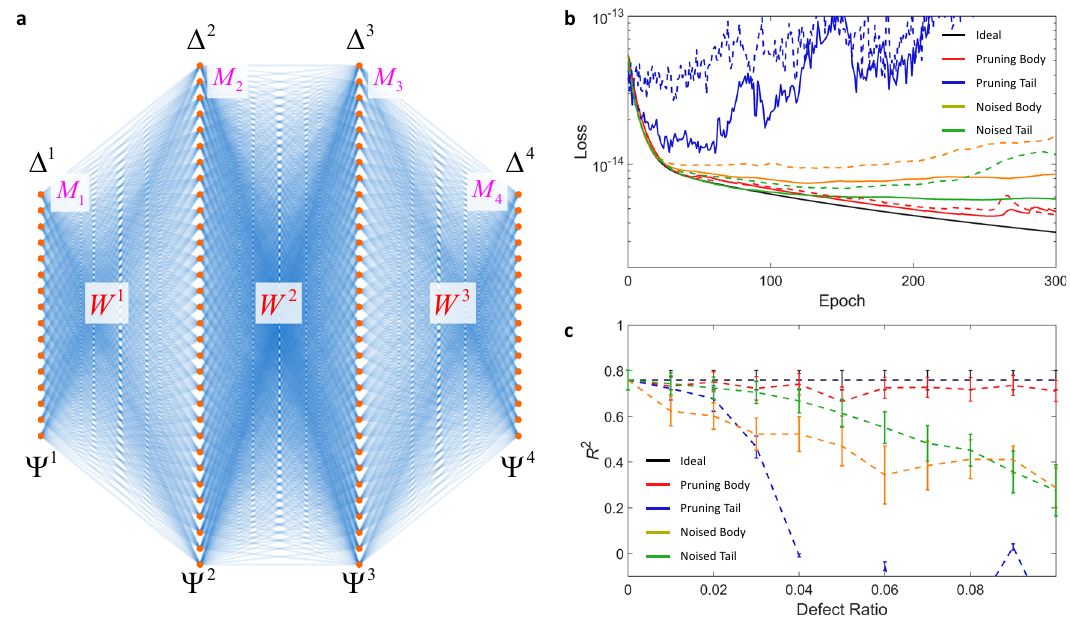
Fig. 5 | Pruning in photonic deep neural networks for regression. a The archi- (red),pruningtail(blue),noisybody(orange)andnoisytail(green).Noisybodyand tecture of the deep neural network for analyzing the effect of pruning. M p ( p =1, 2, noisy tail are shown for δ 0 = 0.001 π . In ( b ), solid and dashed lines denote 5% 3,4)isthenumberofneuronsinthe p thlayer,where M 1 = M 4 =16and M 2 = M 3 =32. (2 σ / n ( n – 1)=0.05) and 10% (2 σ / n ( n – 1) = 0.10) defect ratios, respectively. In p , δ p , ... , δ Mpp (cid:2) T are the signal and error col- p , a p , ... , a Mpp (cid:2) T and Δ p = ½ δ Ψ p = ½ a c , dashed lines and error bars represent the mean value and half of the standard 1 2 1 2 umnvectorsatthe p thlayer,respectively,where a k p and δ k p arethesignalanderror deviation of the test dataset accuracies of 1000 realizations. The disconnection of atthe k thneuronofeachlayer( k =1,2, … , M p ),respectively. W p istheweightmatrix the blue dashedline in ( c ) denotesthe failure of the training due tothe divergence between the p th and ( p +1)th layers. b , c Learning curves ( b ) and R-squared of network parameters. All the other parameters for training and calculating loss accuracies( c )ofthemodel,whichareestimatedwiththetestdataset.Thecolorsof functions are shown in the lines denote the unitary photonic circuits in different groups: pruning body